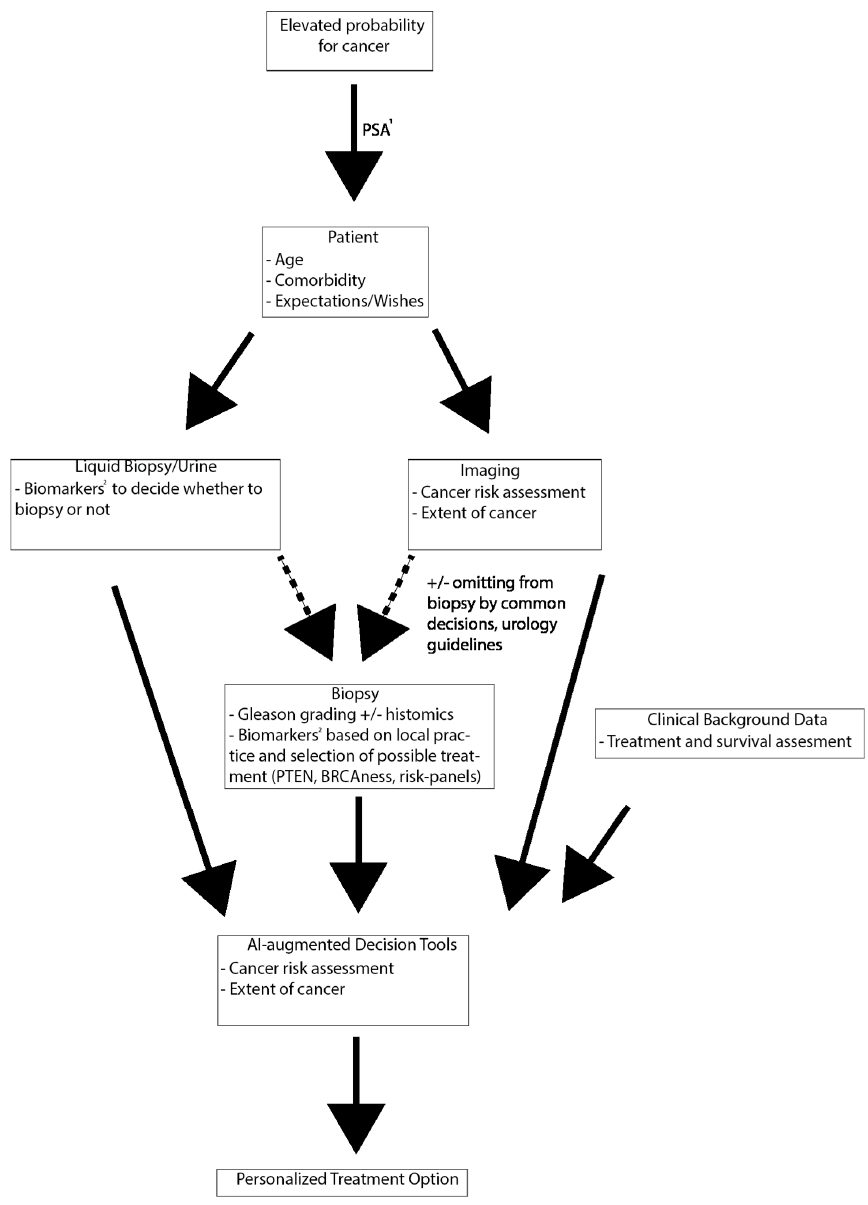
Figure 2. Future prospect of a multimodal diagnostic work-up and treatment decision-making. 1 : Prostate-specific antigen (PSA) is unspecific at the diagnostic phase and should be taken only as part of an informed risk assessment or based on recommendations for personalized screening. 2 :